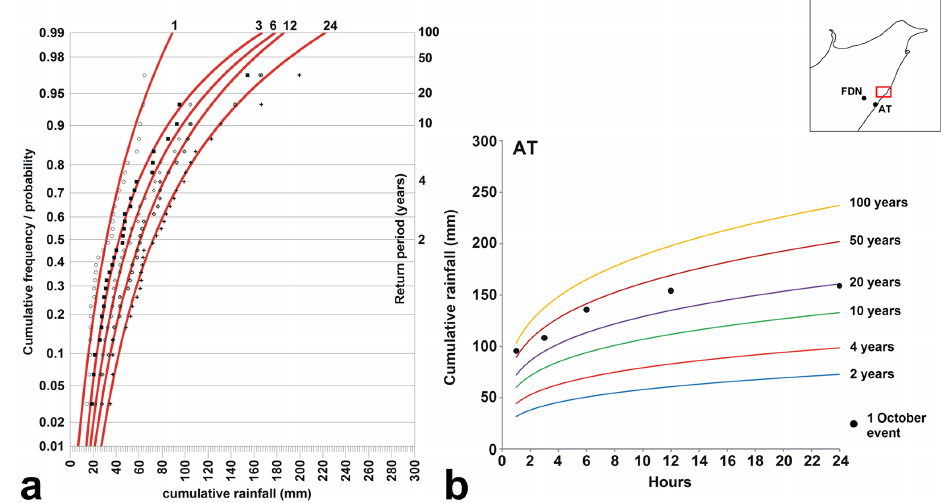
Figure 12. (a) Cumulative frequency and probability according to GEV distribution for 1, 3, 6, 12 and 24h cumulative rainfall for Alì Terme (AT) station; (b) rainfall probability curves for return periods of 2, 4, 10, 20, 50 and 100 years for the same station. The locations of this station and the Fiumedinisi (FDN) station are shown in the sketch on the upper right (the red square represents the study area).